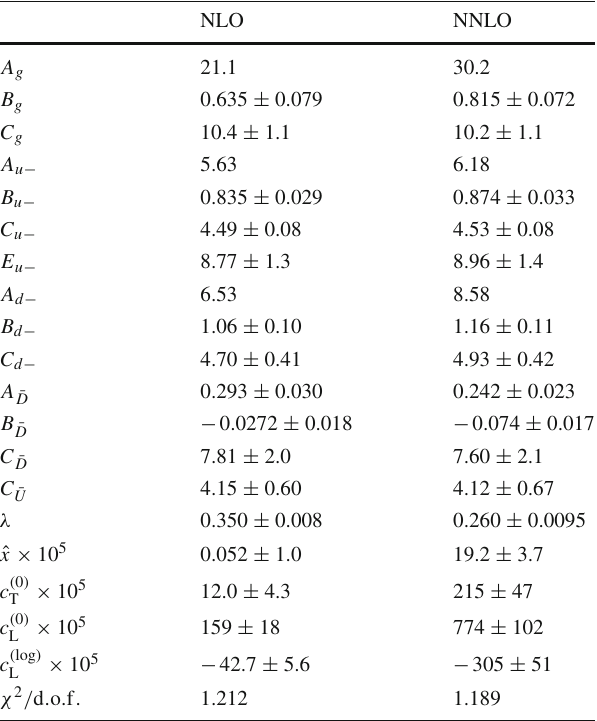
Table 1 Parameters and the χ 2 / d . o . f . values for the HTS NLO and NNLO fits. Note that A g , A u − and A d − are fixed by the sum